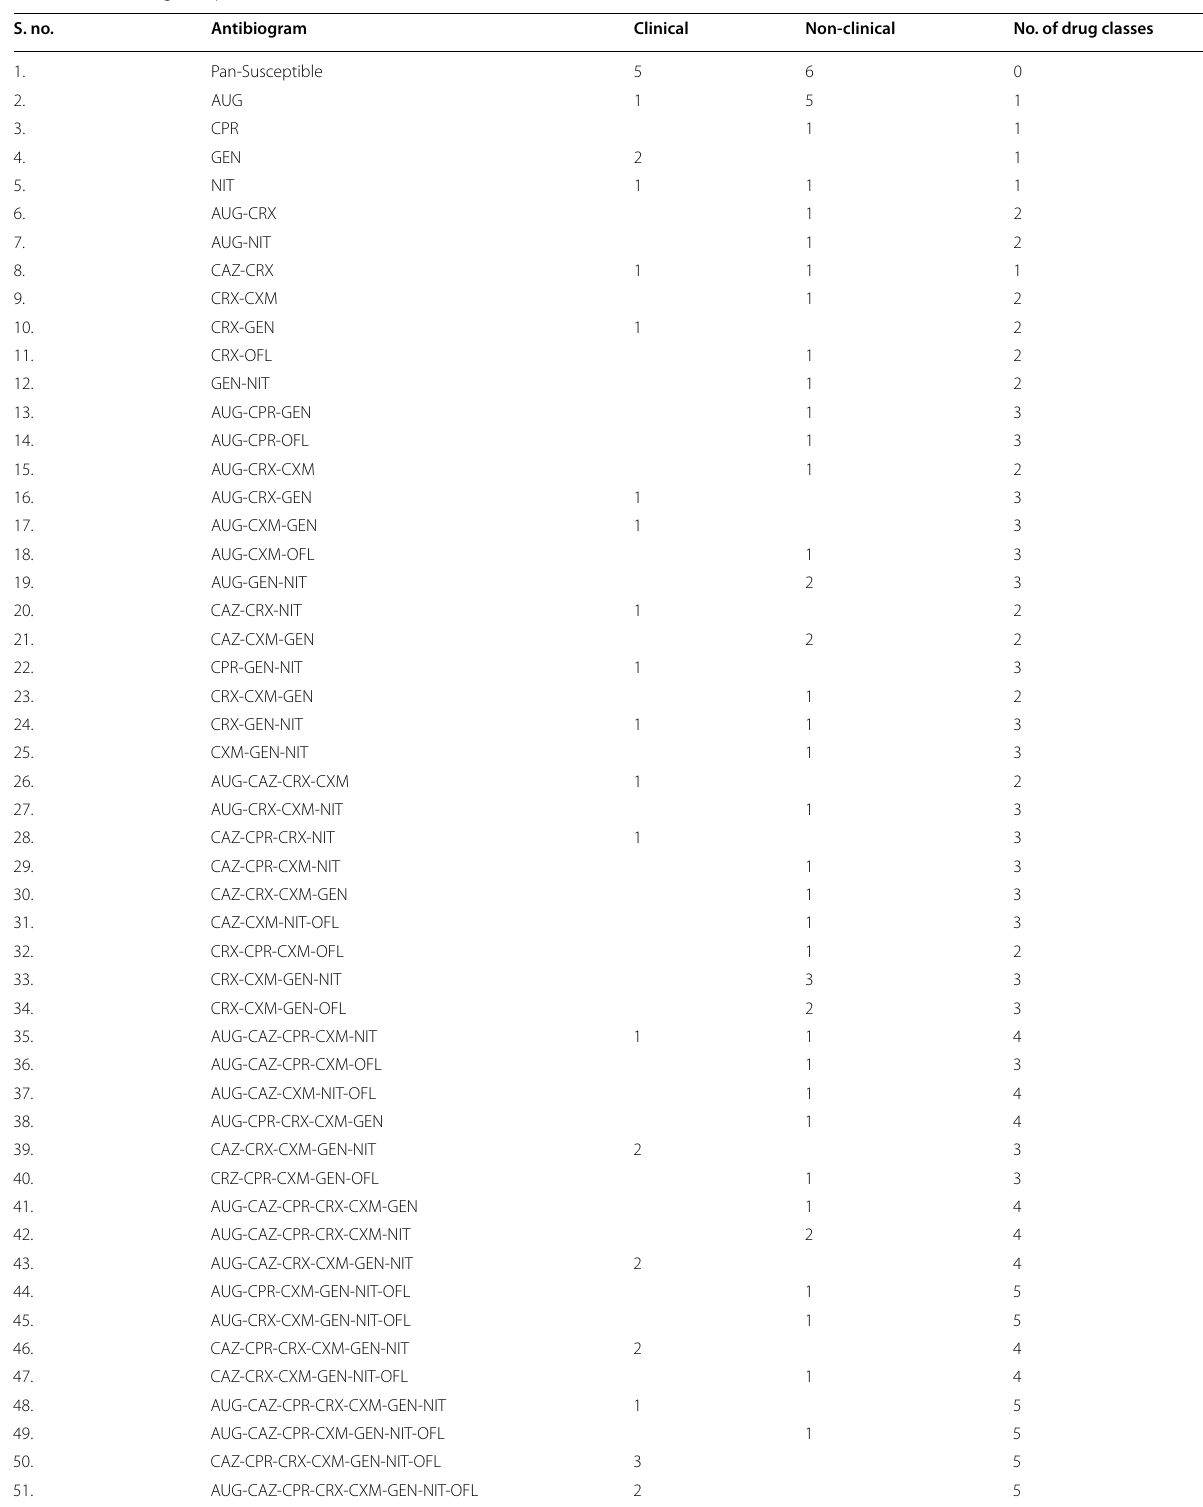
Table 1 Antibiogram pattern of the